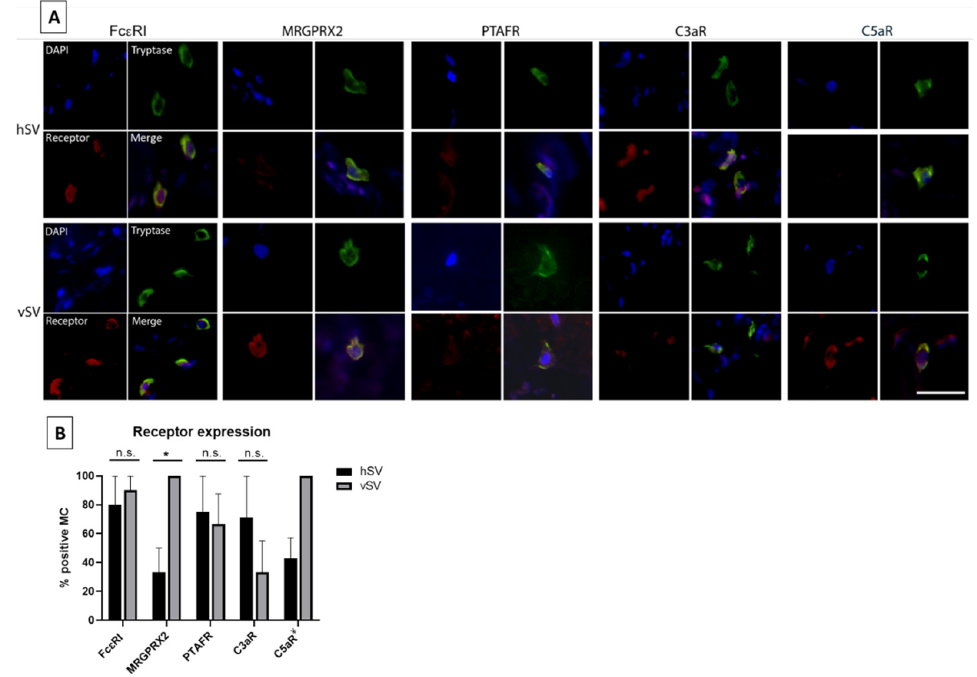
Figure 3. Receptor expression in mast cells (MCs) from vein. ( A ): Several 4 µ m paraffin sections of varicose saphenous vein (vSV, n = 5) or healthy saphenous vein (hSV, n = 3 ¥ ) were stained for tryptase to identify MCs and co-stained with either Fc ε RI, MRGPRX2, PTAFR, C3aR, or C5aR. Scale bar: 20 µ m. ( B ): Comparison of receptor expression between hSV and vSV. For each vein, the number of MCs expressing the specific receptor was counted and compared to the total number of MCs present (based on tryptase expression). * p < 0.05, n.s.: non-significant p -value. ¥: n = 2 for C5aR expression due to lack of MC detection.